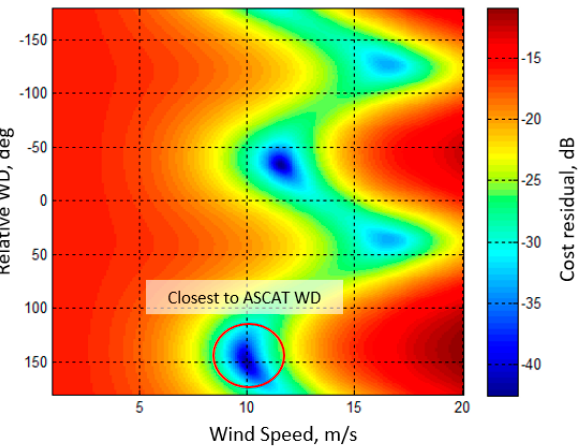
Figure 4. Example of HIWRAP cost error surface for a clear-sky OVW retrieval during TBRE.